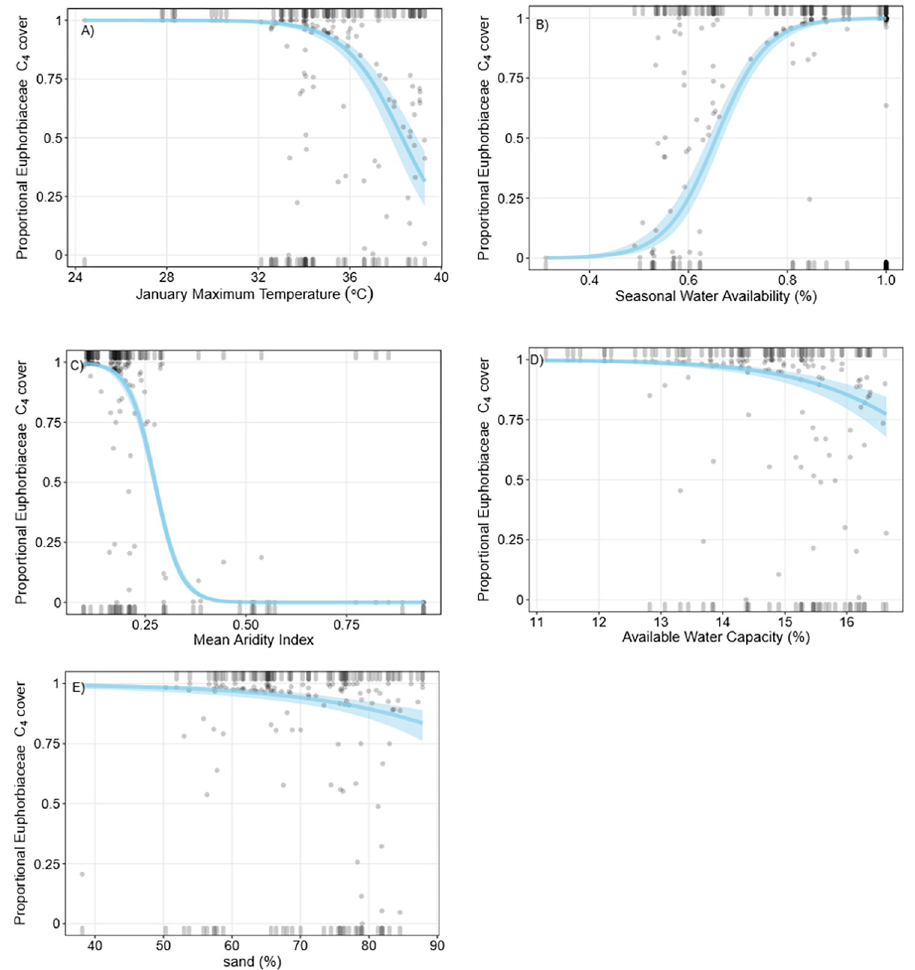
Fig 9. Binomial logistic regressions of proportional C 4 Euphorbiaceae cover. Grey points are partial residuals, blue lines and shaded bands are predicted outcomes of the regression and 95% confidence intervals respectively, and rugs were drawn to indicate observations with positive residuals (top of the plot) or negative residuals (bottom of the plot). For each plot, independent variables not depicted on the x-axis were held constant at their median value.